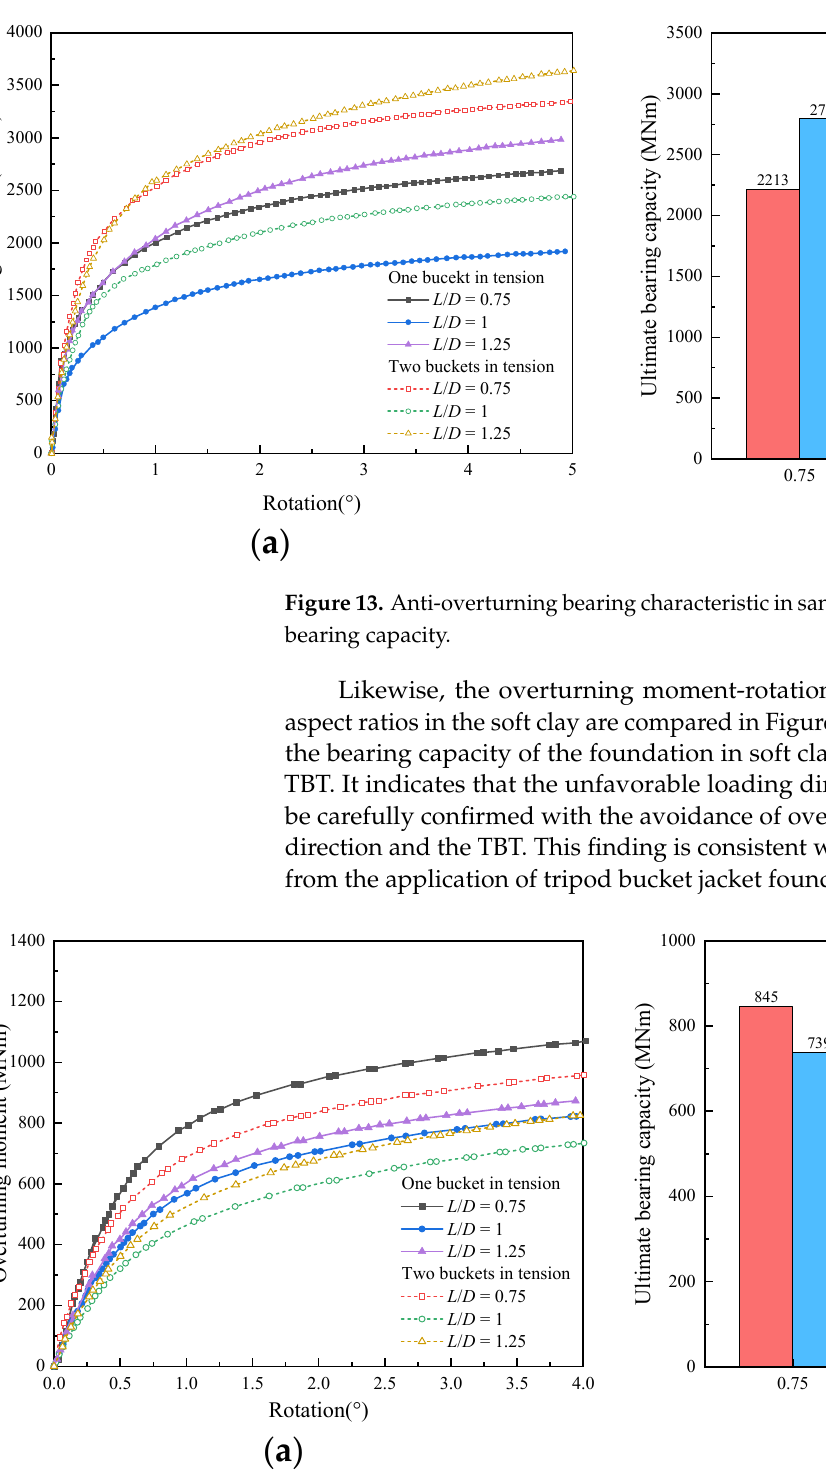
( b ) Figure 12. Comparison of measured and computed overturning response of fi led test: ( a ) Frederik- shaven, ( b ) Sandy Haven. 4. Comparison Study in Engineering Scale 4.1. Anti-Overturning Bearing Capacity Figure 13a displays the overturning moment-rotation curve of the tripod bucket foundation with di ff erent L / D in sand. The tripod foundations with di ff erent aspect ratios have similar initial sti ff ness in two opposite loading directions, which agrees with the ob- servation obtained from Figure 7 and the literature [14]. The bearing capacity of the foun-